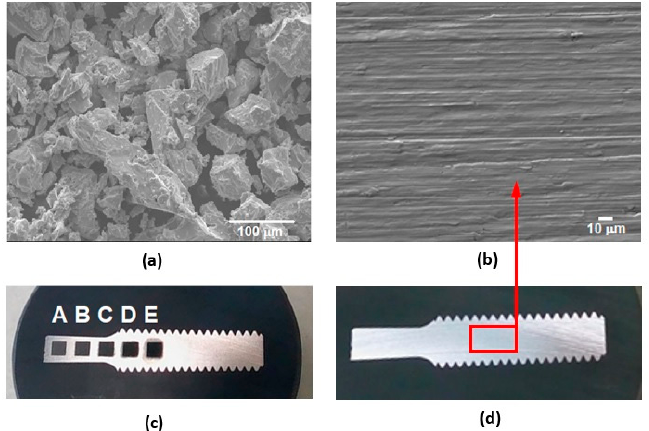
Figure 1. Experimental sample: ( a ) scanning electron microscopy (SEM) image showing a characteristic fragmented shape of the used HDH titanium powder, original magnification of 250 × , ( b ) SEM image of the sample surface before machining, original magnification of 500 × , ( c ) experimental sample after laser machining, ( d ) experimental sample before laser machining. Table 1. Mechanical properties of the low temperature PM processed titanium compacts compared with the properties of the CP Ti Grade 1 [42].